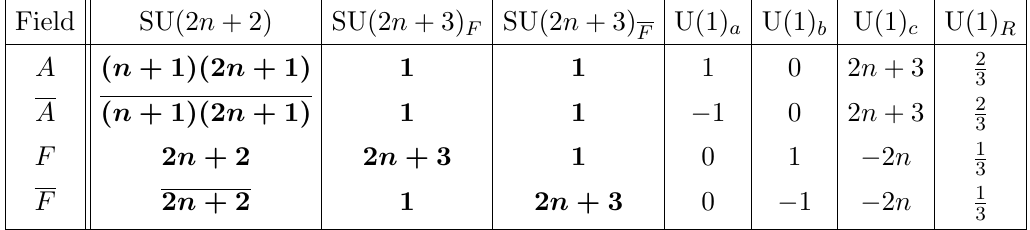
theory, shown with their (2 ; 2 n +1)